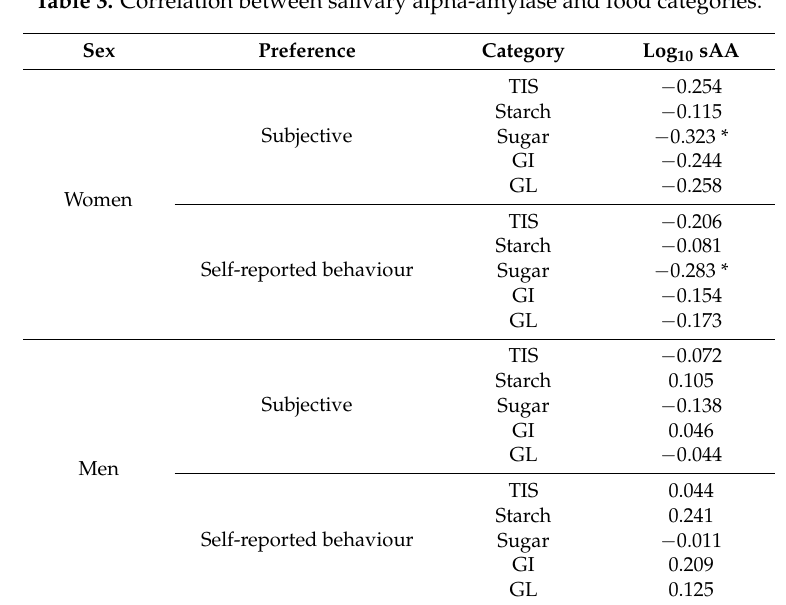
Table 3. Correlation between salivary alpha-amylase and food categories.